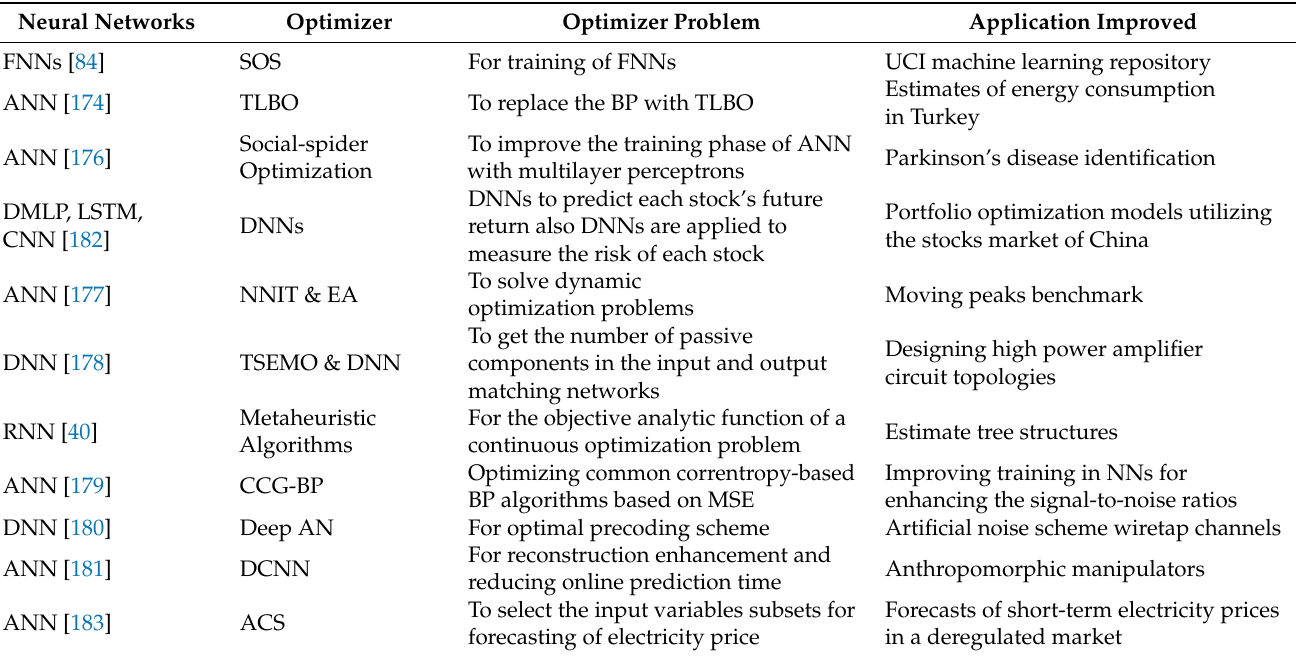
Table 8. Overview of a variety of optimization techniques based on neural network design and application enhancement. Neural